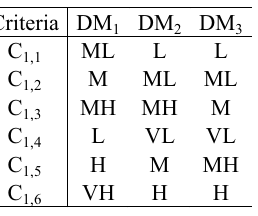
Table 3. Evaluation of the weights of criteria